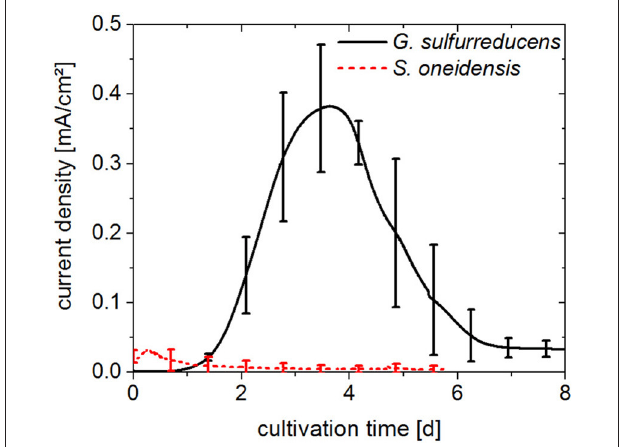
FIGURE 2 | Chronoamperograms (first cultivation cycle) from pure cultures of G. sulfurreducens fed with 10mM acetate (solid line) and S. oneidensis fed with 5mM acetate and 5mM lactate (dotted line). Anode potential: 0.2 V Ag / AgCl . Error bars represent standard deviation of biological triplicates. Samples were taken at the beginning and end of